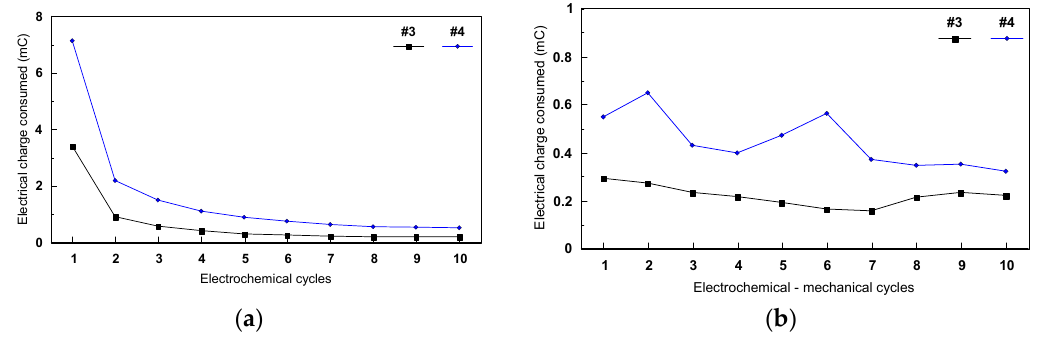
( b ) Figure 22. The fatigue corrosion behavior of Ti-based alloys in 9g/L NaCl during the mechanical cycles: ( a ) static and ( b ) dynamic cycles. During the dynamic cycles, the values of the consumed electrical charge were between 150 and 700 mC, much smaller than those determined for the static tests. For each tested specimen, the